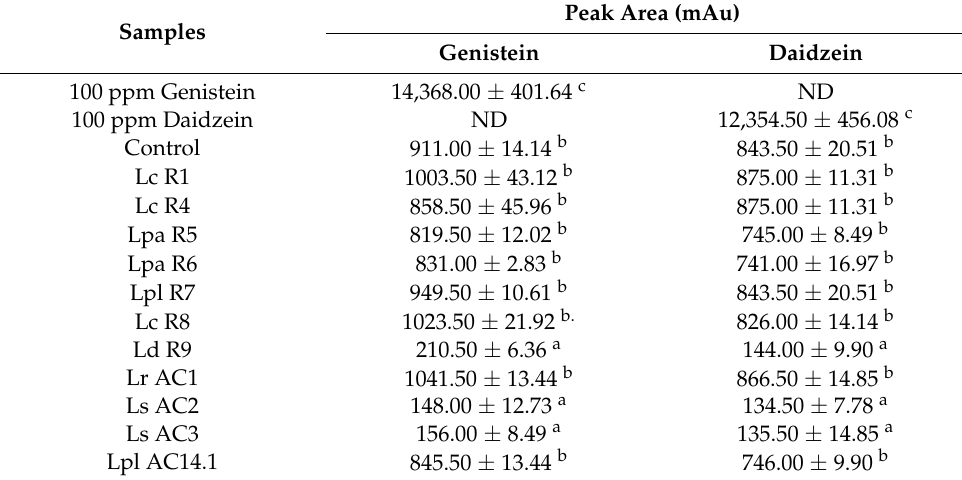
Table 3. Content of main isoflavone forms, genistein and daidzein, in the soymilk fermented by LAB isolates after 48 h. Peak Area (mAu) Samples Genistein Daidzein 100 ppm Genistein 14,368.00 ± 401.64 c ND 100 ppm Daidzein ND Control 911.00 ± 14.14